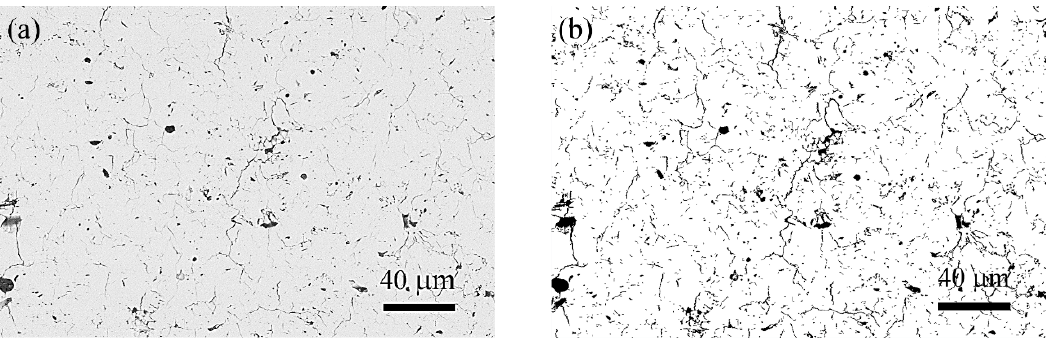
Figure 2. The process of extracting the pore characteristics of the coating (45–60 μ m, after heat pre ‐ treatment): ( a ) SEM image and ( b ) image binarization and extraction of pores.